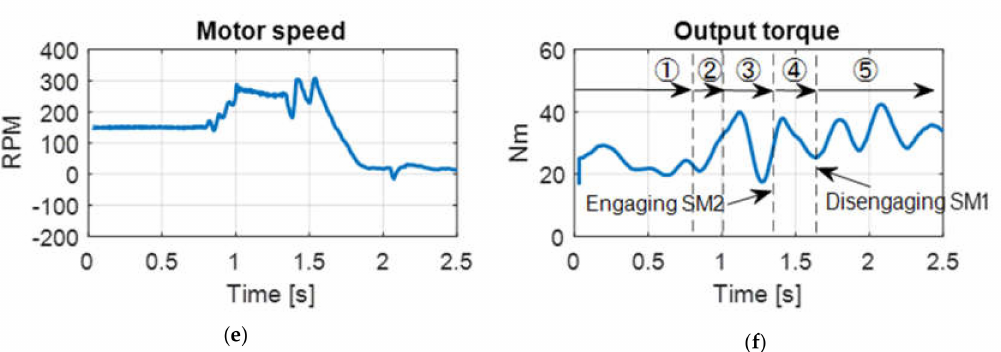
Figure 14. Experimental results of shifting from odd to even gear-stage (from 1st to 2nd): ( a ) Engine throttle angle; ( b ) PGS speed; ( c ) Engine speed; ( d ) Gear stage and flywheel speed; ( e ) Motor speed; ( f ) Output torque during shifting phases ( 1 (cid:79) 1st gear driving, 2 (cid:79) Speed synchronization (Motor torque control), 3 (cid:79) Speed synchronization (motor speed control), 4 (cid:79) Torque control, 5 (cid:79) 2nd gear driving).